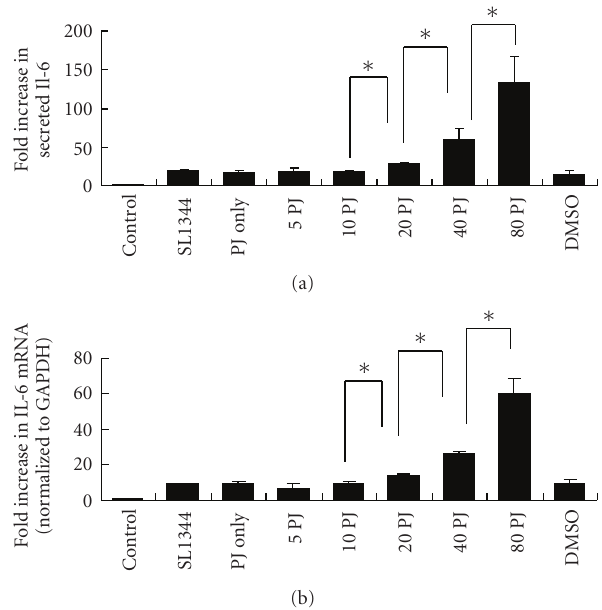
Figure 1: (a) E ff ect of PJ-34 on Salmonella -induced IL-6 protein secretion. Caco-2 cells were left untreated (control), or treated with 5, 10, 20, 40, or 80 μ M PJ-34 (5, 10, 20, 40, 80PJ), or with a volume of DMSO (D) equivalent to the highest concentration of PJ-34. They were then uninfected (control and PJ only) or infected with the wild-type S . typhimurium strain SL1344 for 1 hour. Supernatant was analyzed by ELISA 6 hours later for IL-6. The amount of IL-6 produced is shown as the fold increase over uninfected, control cells. The results are representative of the results of two similar experiments. The data are the means ± standard deviations for three determinations. ∗ P < . 05. (b) E ff ect of PJ-34 on Salmonella -induced IL-6 mRNA. Caco-2 cells were left untreated, or treated with 5, 10, 20, 40, or 80 μ M PJ-34. They were then uninfected or infected with the wild-type S . Typhimurium strain SL1344 for 1 hour. Total RNA was prepared 3 hours later and analyzed by real-time quantitative PCR to estimate amounts of IL-6 transcript. The amount of IL-6 mRNA produced, normalized to the corresponding amount of GAPDH transcript, is shown as the fold increase over uninfected, control cells. The results are representative of the results of two similar experiments. The data are the means ± standard deviations for three determinations. ∗ P < .